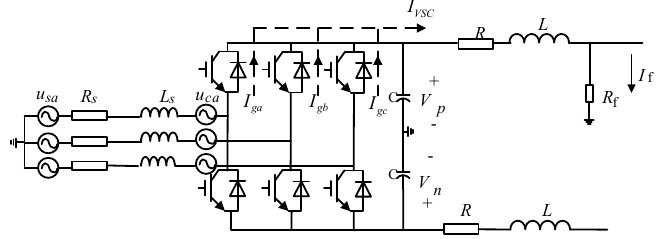
Figure 2. Schematic diagram of the power grid side feeding stage.